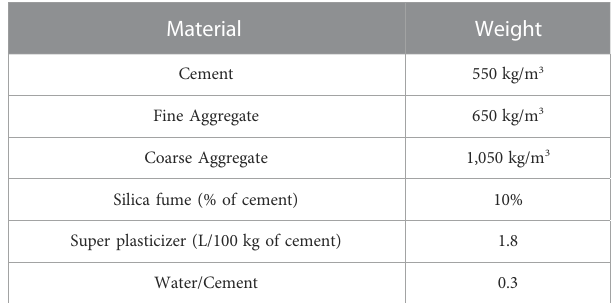
TABLE 4 Concrete mix